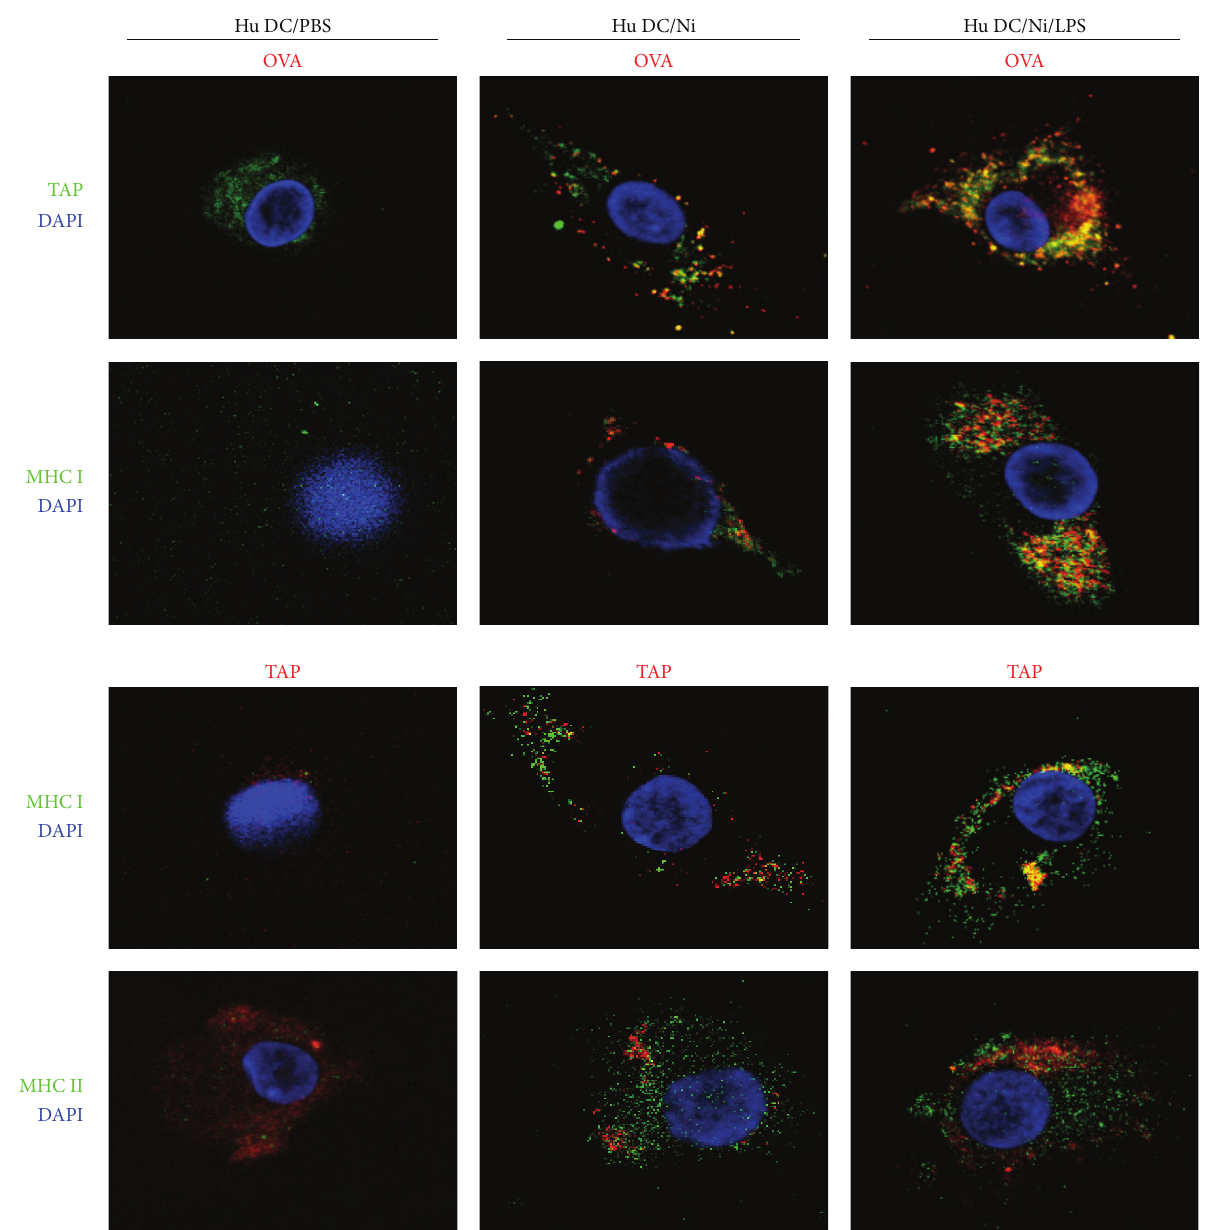
Figure 4: The exposure of traces of LPS increases TAP-OVA-MHC class I molecules complex formation in human semimature DCs. DCs derived from human PBMC with recombinant human GM-CSF and IL-4 were conferred with nicotine (10 −7 mol/L) 12 ∼ 15h stimulation. Then, the DCs were exposed to 60 min endotoxin-free EndoGrade-ovalbumin (50 𝜇 g/mL) pulse and 20 min LPS (1ng/mL) stimulation . The effect of nicotine and LPS on the complex formation of TAP, OVA, and MHC class I molecules was observed by confocal microscope analyses. One representative from 3 independent experiments is shown. Ni: